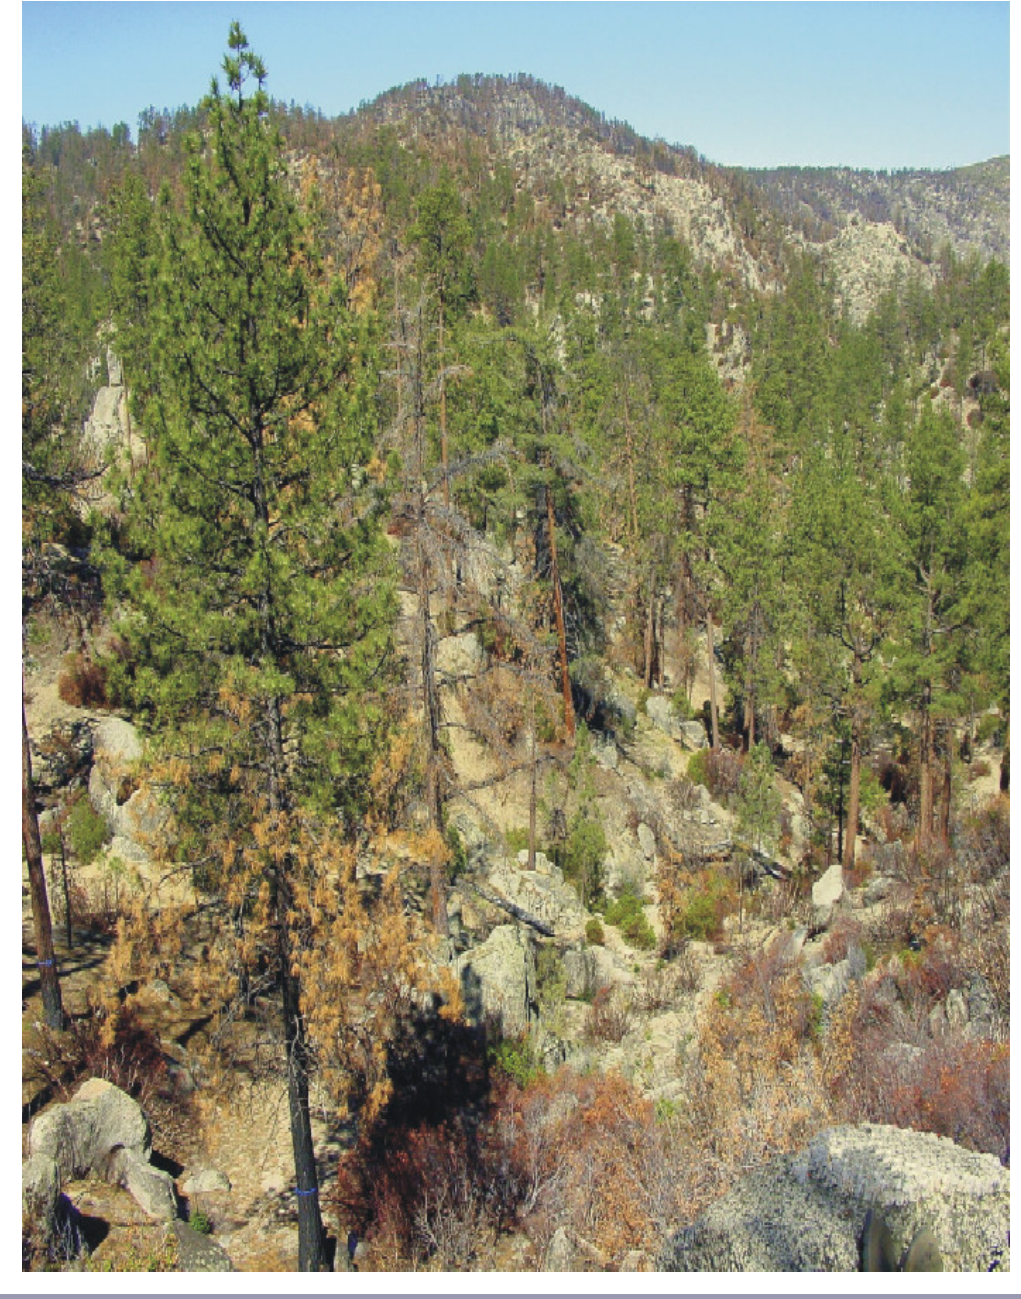
Fig. 1. This photo of an unmanaged Jeffrey pine-mixed conifer forest was taken 3 yr after a 2003 wildfire in northern Sierra San Pedro Martir (SSPM), northwestern Mexico, the first fire in this area in several decades. Observations of average forest stand characteristics, i.e., tree and snag density, basal area, fuel loads, are uncommon in these forests. This spatial heterogeneity is due to recurring disturbances such as fire, which influence landscape